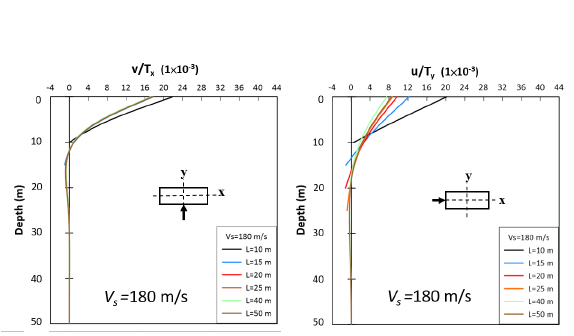
Fig. 18. Normalized deflections of the barrette in sands ( v s